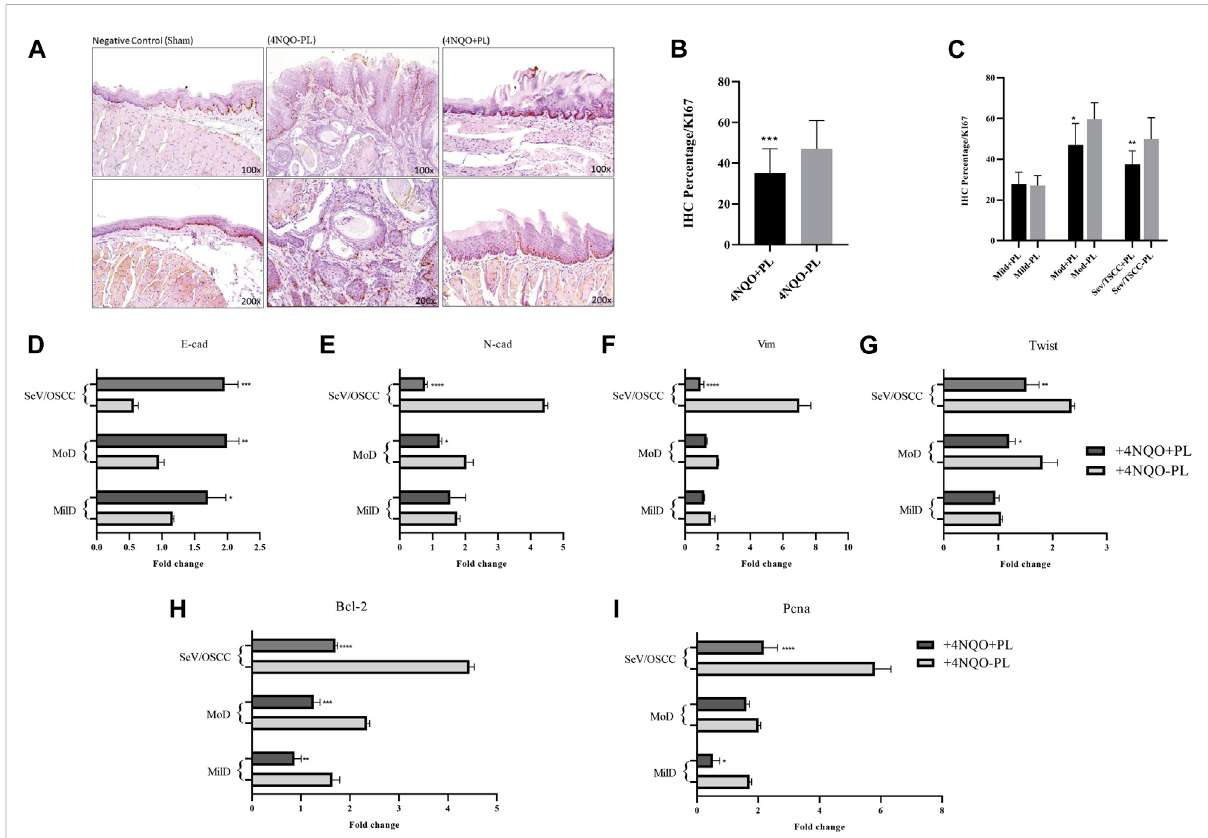
FIGURE 6 Representative image of Ki-67 IHC analysis of histological sections of the tongue of mice 4NQO-induced and treated or not with PL. (A) Representative IHC of the tongue tissue of control mice without 4NQO-induction (Sham), showing Ki-67 staining in the epithelial basal layer; (+4NQO-PL) Cells exhibiting positive immunoreactivity for Ki-67 in Tongue Squamous cell carcinoma in situ (mice not treated with PL), exhibiting staining and distribution in the basal, suprabasal and spinous layers; (+4NQO + PL) Moderate to weak staining of Ki-67 in area of epithelial dysplasia of mice treated with PL. Upper panel: ×100 magni fi cation; lower panel: ×200 magni fi cation. (B) Overall quanti fi cation of Ki-67 showed a signi fi cantly lower expression of this marker in the group of mice treated with PL. (C) Distribution of Ki-67 staining among tongue lesions of animals treated and not treated with PL; showing signi fi cantly lower expression of Ki-67 in moderate dysplasia and SCC of PL-treated mice. (D – G) Gene expression analysis of EMT markers E-cadherin, N-Cadherin, Vimentin, and transcription factor Twist 1, in oral dysplastic and Tongue SCC tissues of micetreatedwithPL,incomparisonwithnot-treated. (H – I) Quanti fi cationmRNAexpressionofgenesassociatedwithproliferation,Bcl2andPcna,in oraldysplasticandSCCtissuesofmicetreatedwithPL,incomparisonwithnot-treated.Thegraphscompileexperimentalduplicateanalyses,andthe results were obtained by ANOVA followed by Tukey assay, where * p < 0.05, ** p < 0.01, *** p < 0.001, **** p <